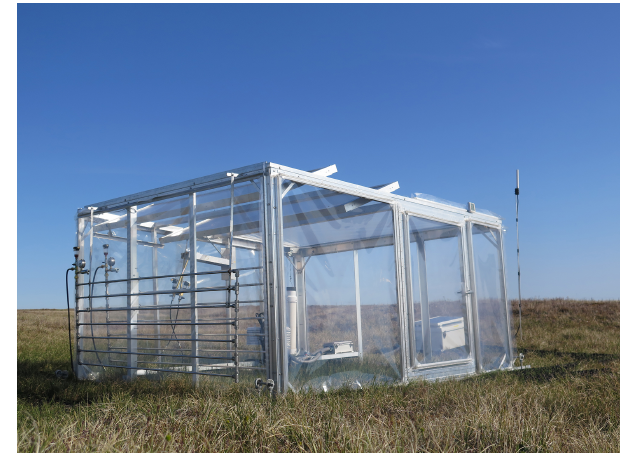
Figure 2. The ZPW chamber pictured on coastal tundra near Barrow, AK. The chamber measures 2.4m × 2.4m × 1.4m (L × W × maximum H). In this picture, the two vents are partially open due to the temperature differential between the internal and external heat exchangers that are visible on the near wall of the chamber. The brass pistons and counterweight (section of white PVC pipe) can be seen opposite the door. The near corner obscures the view of most of the monitoring instrumentation but the junction box can be seen in the centre of the far wall. Outside and behind the chamber you can see a box with a solar panel that contains a data logger and battery to power the monitoring instrumentation, and an antenna for data